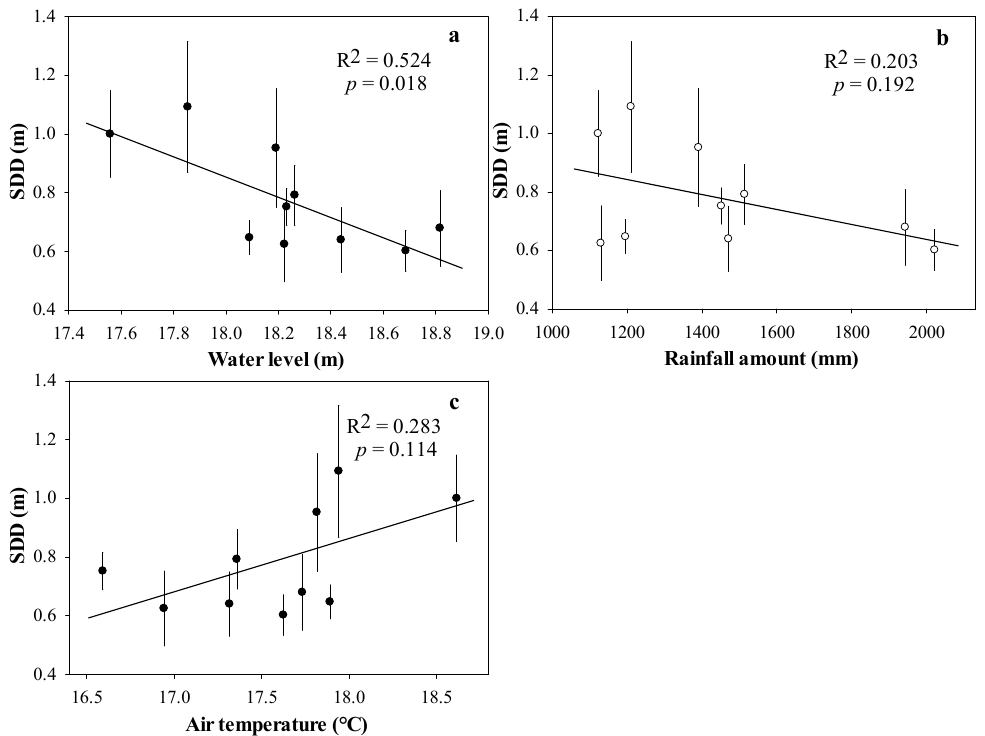
Figure 10. Correlations of the SDD with ( a ) water level, ( b ) rainfall amount, and ( c ) air temperature. Error bars represent SDD standard deviations.